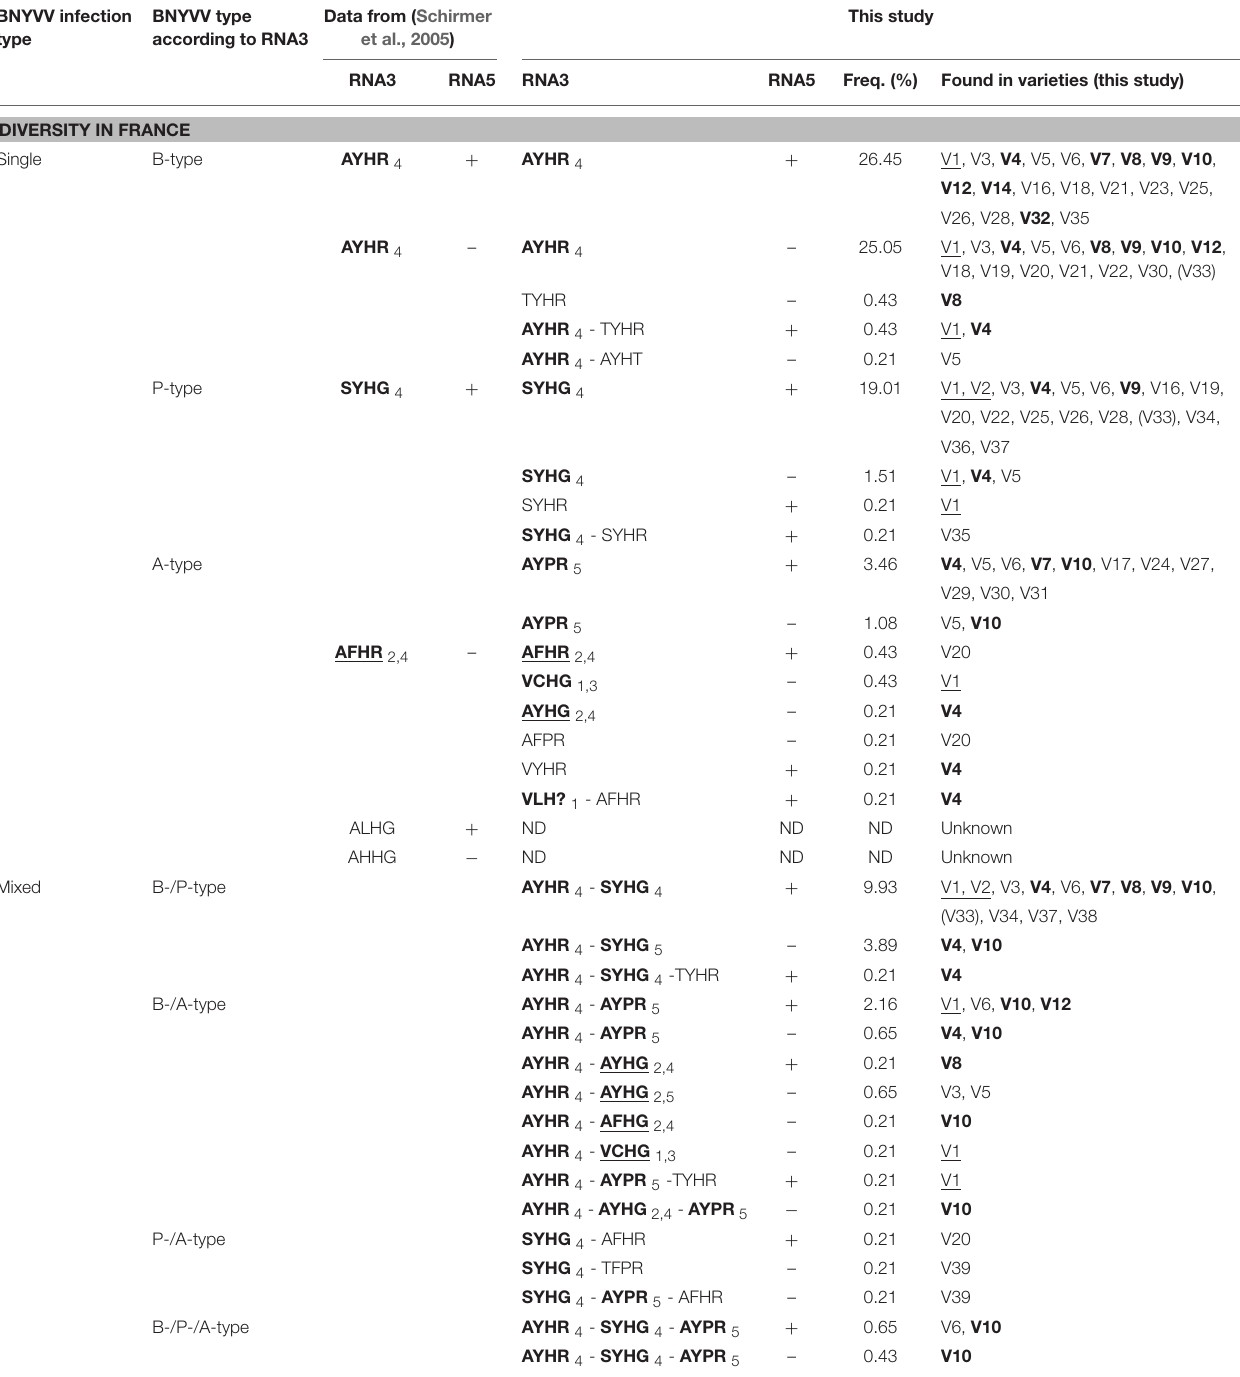
TABLE 3 | Tetrad diversity observed in the Pithiviers region in France based on 482 isolates of Beet necrotic yellow vein virus (BNYVV) collected from year 0 to year 3. BNYVV infection